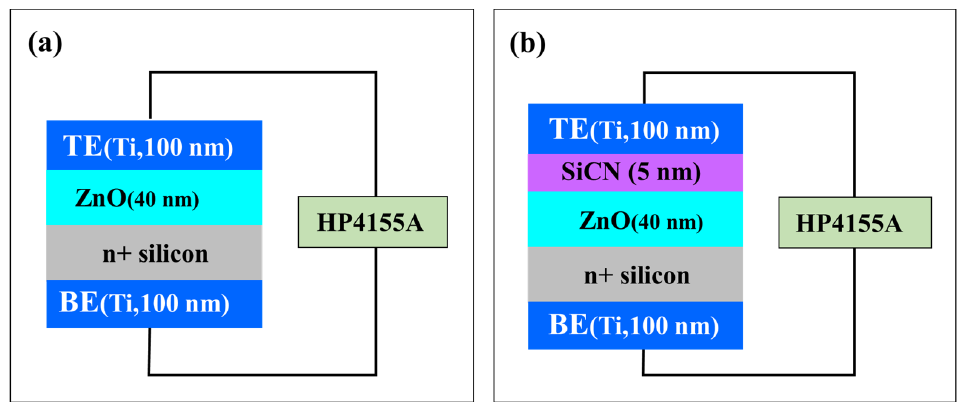
Figure 1. Schematic of RRAM with ( a ) the conventional TE (Ti, 100 nm)/ ZnO (40 nm)/ n+Si/ BE (Ti, 100 nm), and ( b ) the suggested TE (Ti, 100 nm)/ SiCN (5 nm, 4MS PPR 5.2%)/ ZnO (40 nm)/ n+Si/ BE (Ti 100 nm) structure.